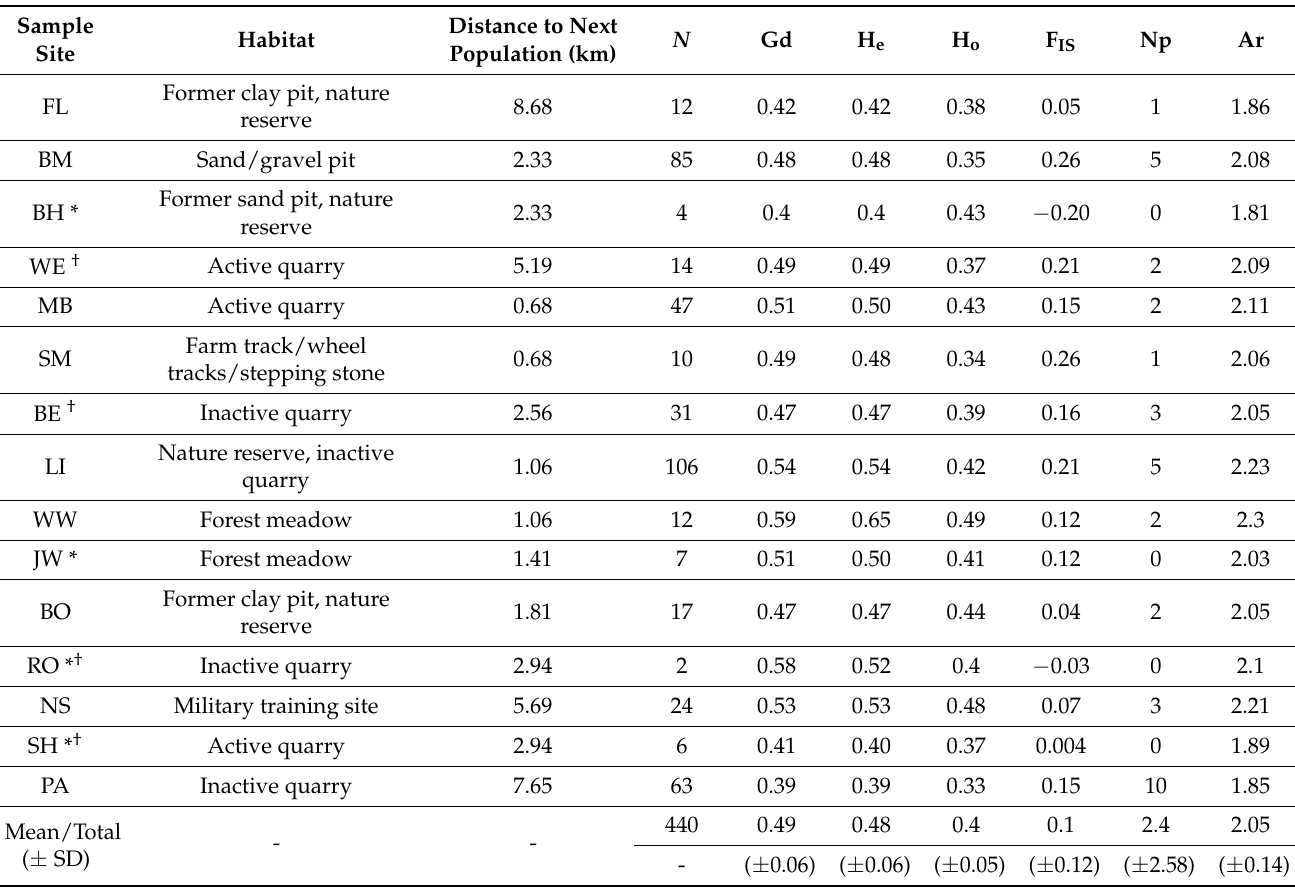
Table 3. Summary of diversity indices for yellow-bellied toads in northern Weser Hills at 15 sample sites. Sample size (“ n ”), gene diversity (“Gd”), expected heterozygosity (“H e ”), observed heterozygosity (“H o ”), fixation/inbreeding coefficient (“F IS ”), number of private alleles (“Np”), allelic richness (“Ar”), standard deviation (“SD”), * = n < 10. † = reintroduced populations, n total individuals =